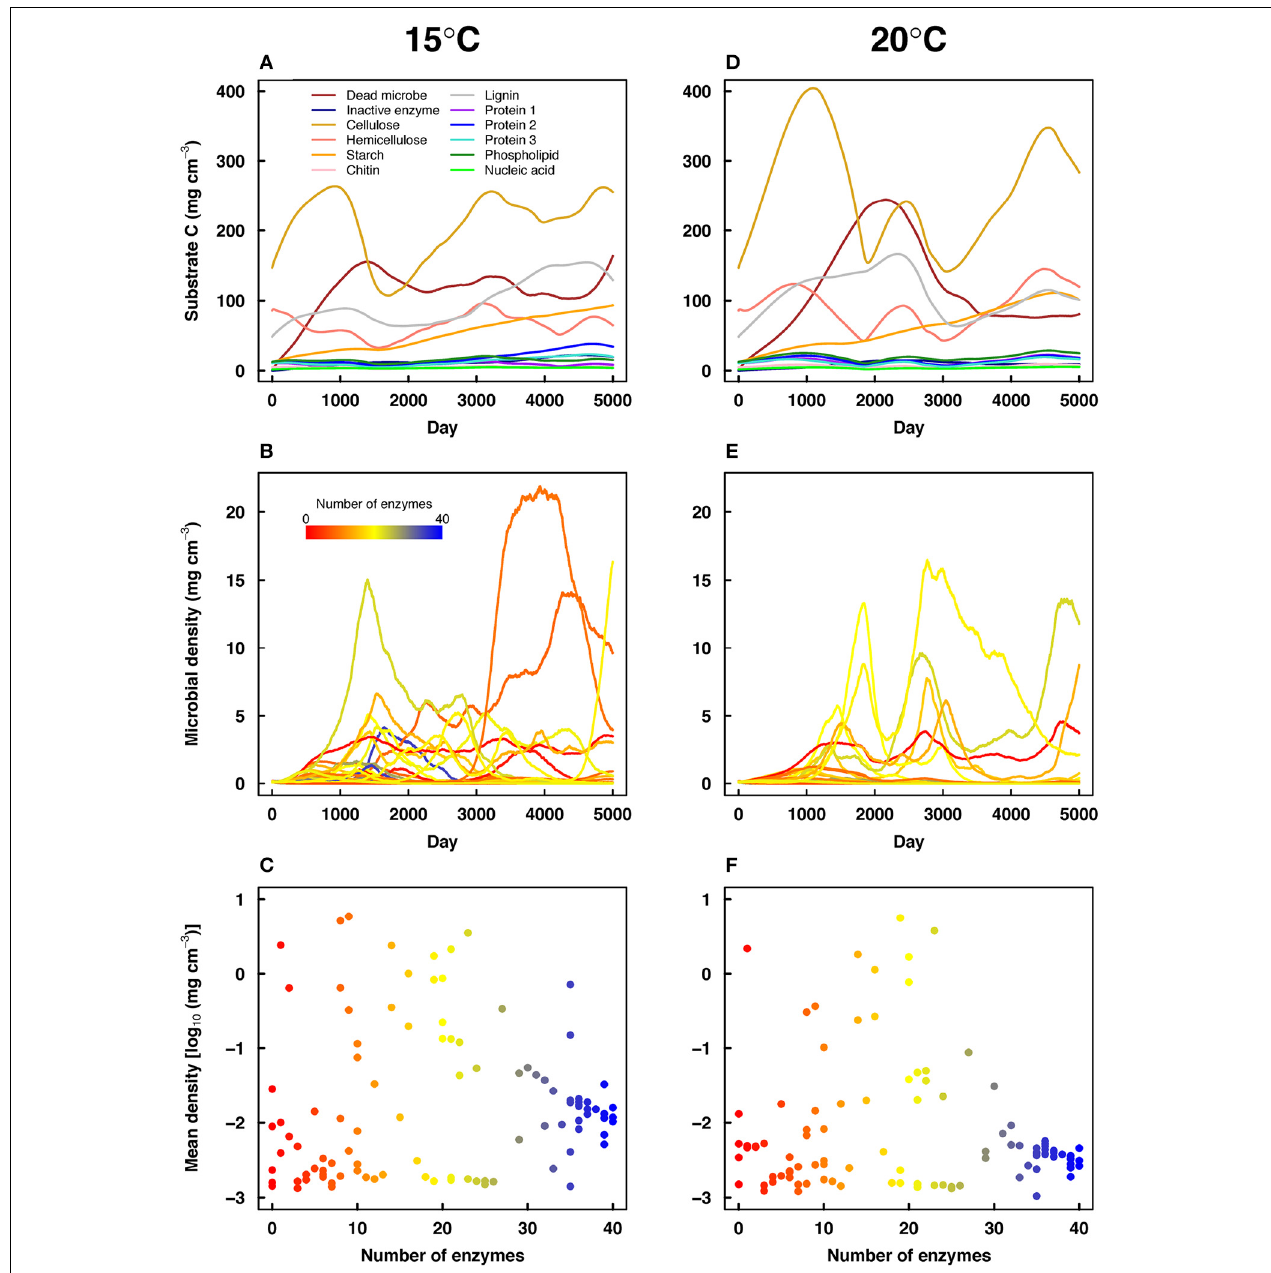
FIGURE 4 | Substrate dynamics (A,D), microbial dynamics (B,E), and mean microbial abundance vs. the number of enzymes possessed by each taxon (C,F) in a selected pair of high